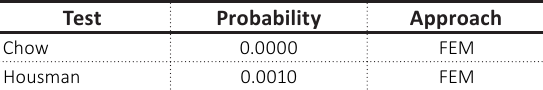
Table 3. Selection of the regression model